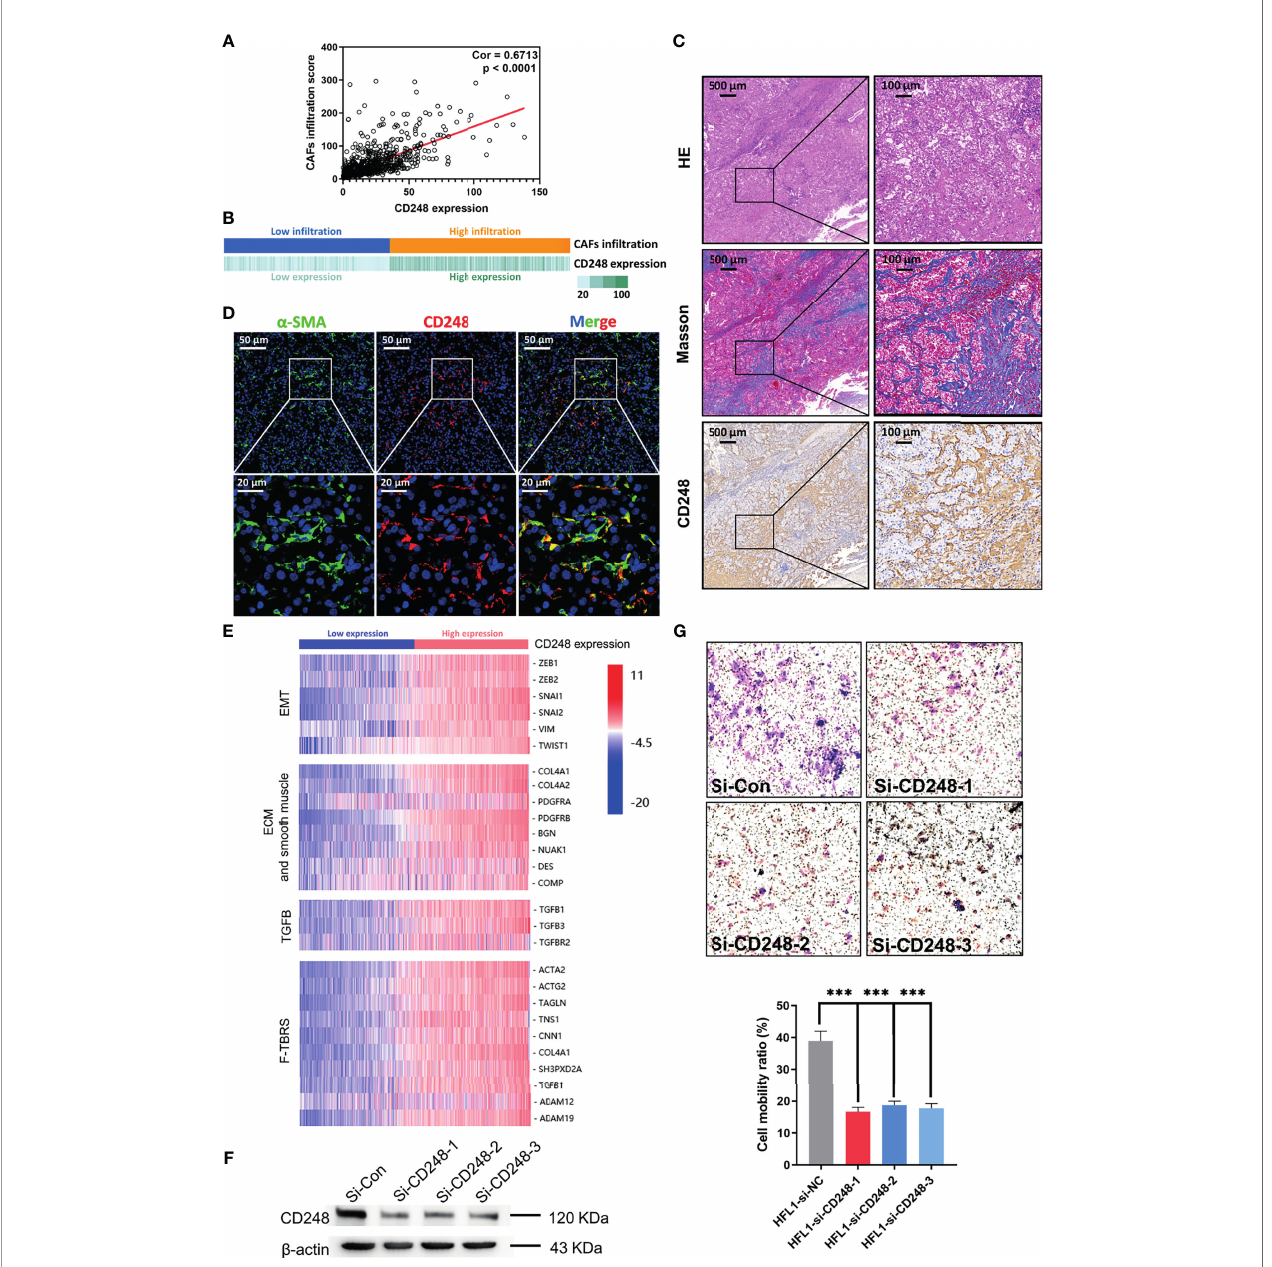
FIGURE 3 | CD248 is a speci fi c biomarker for CAFs. (A) Correlation analysis between CD248 expression and CAF in fi ltration. (B) Correlation bar chart between CD248 expression and CAF in fi ltration. (C) H&E, Masson, and IHC staining for CD248 in RCC tumor lesions. Scale bar = 500 m m. (D) Dual IF staining showing the colocalization of a -SMA (green) and CD248 (red) in RCC tumor lesions. Scale bar = 50 m m. (E) Hierarchical clustering in the TCGA cohort. (F) Western blot showing the effective knockdown of CD248 in the HFL-1 cell line. (G) Images of the Transwell assay results following the knockdown of CD248 in HFL-1 cell lines, and representational statistical analysis of the Transwell assay. n = 3. Data are shown as the mean ± SEM. Representative images are shown. p < 0.05 was considered statistically signi fi cant. *** p <